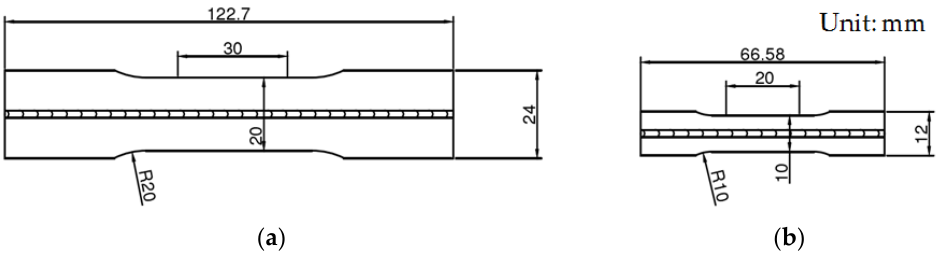
Figure 1. Sketches of the uniaxial tensile test samples with two different dimensions: ( a ) large size; and ( b ) small size.